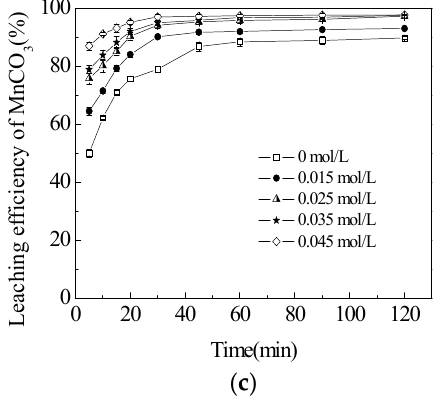
Figure 3. Effect of sucrose concentration on the leaching efficiencies of total Mn (TMn) ( a ); MnO 2 ( b ); and MnCO 3 ( c ) in semi-oxidized manganese ore. The data points represent the average values from the triplicate experiments and the error bars represent the 95% Cls.